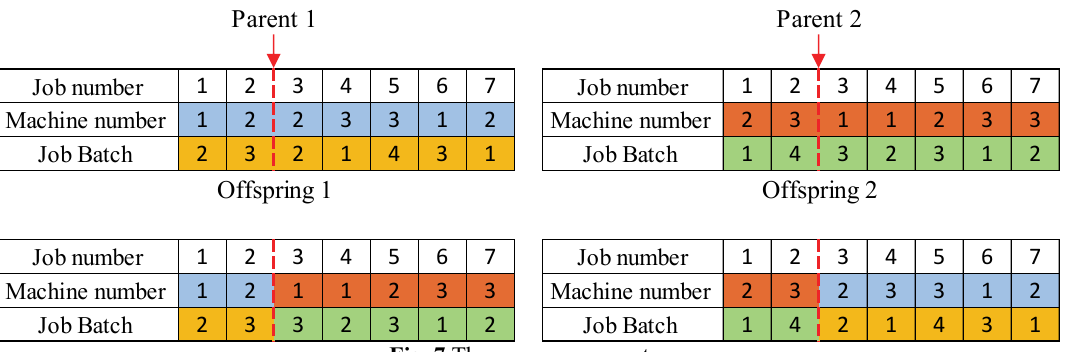
Fig. 7 The crossover operator